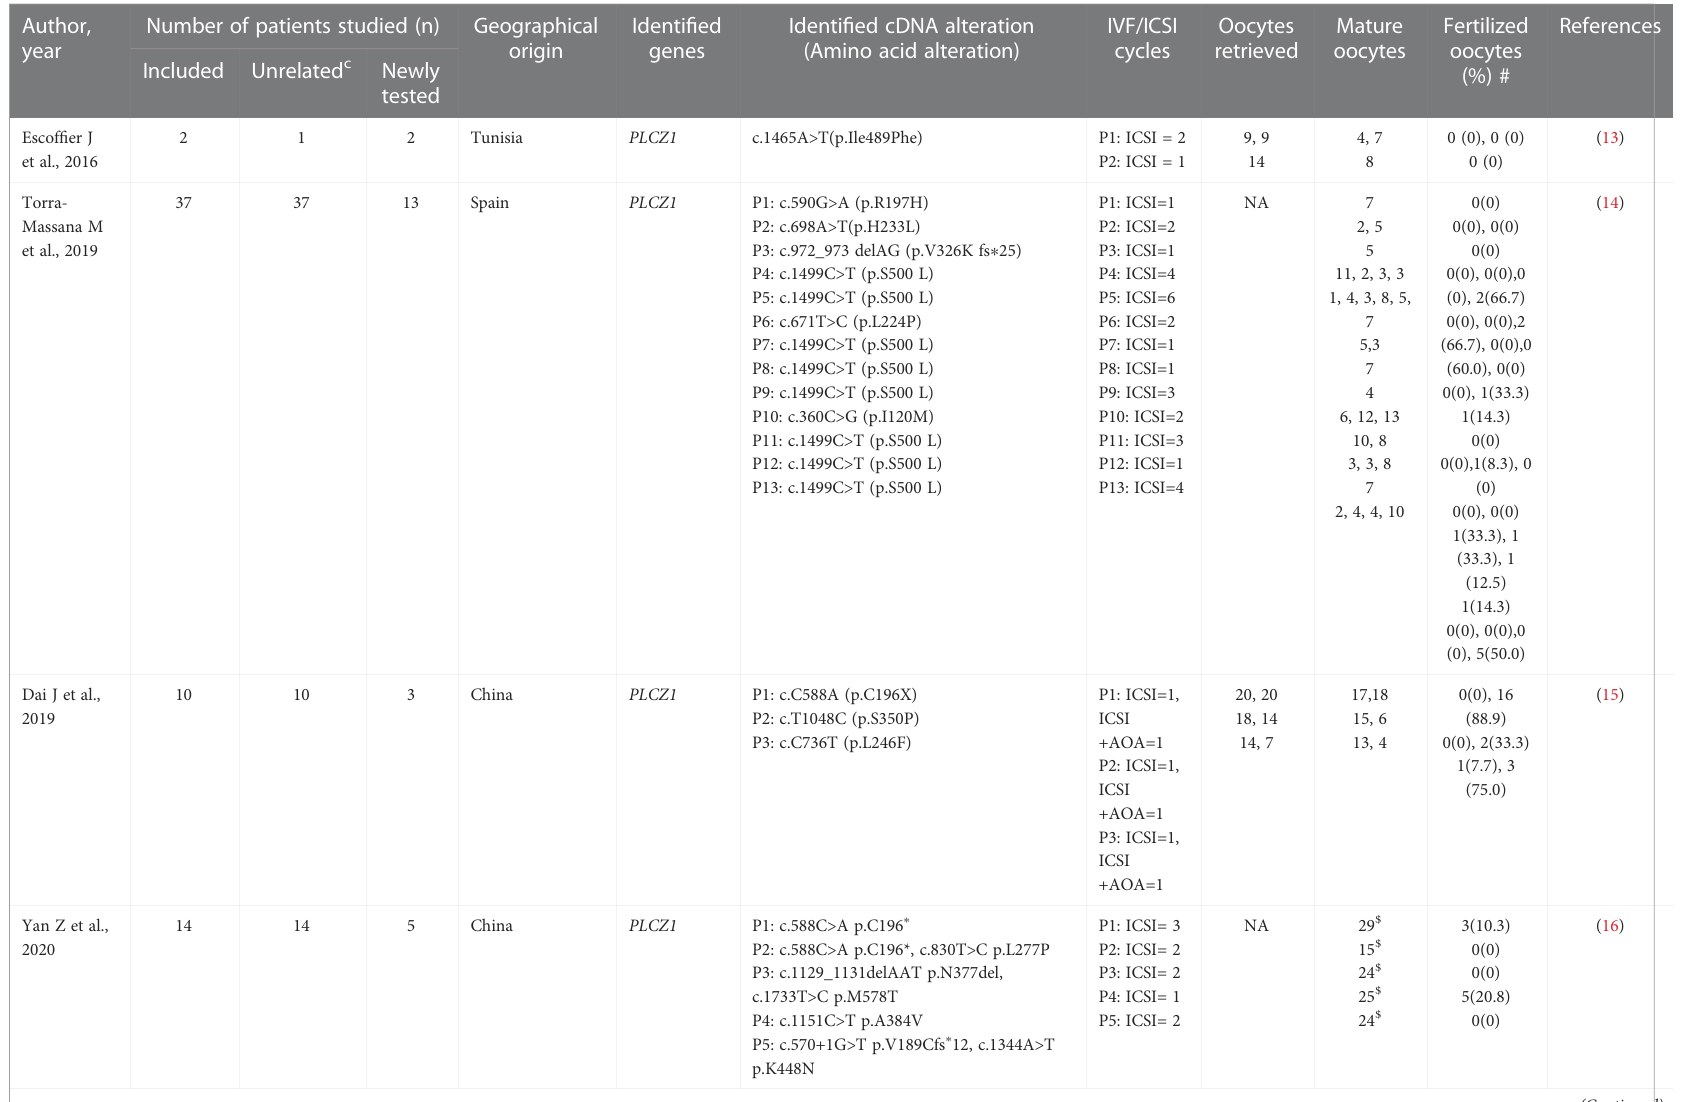
TABLE 1 Details of included studies on gene mutations that lead to poor and failed